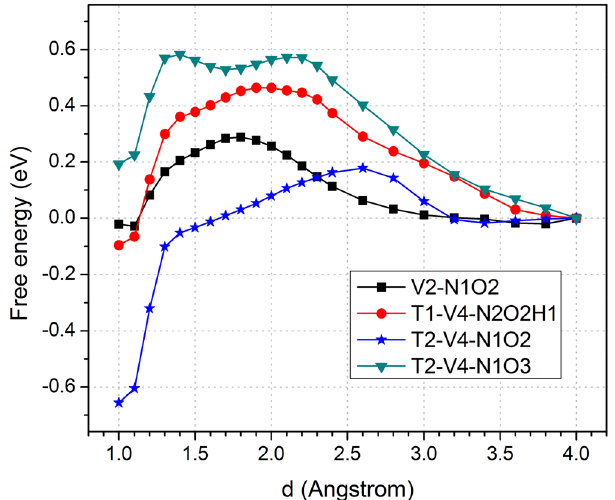
Figure 4. Proton transport free energy profiles for V2-N1O2, T1-V4-N2O2H1, T2-V4-N1O2 and T2-V4- N1O3 structures, respectively. Here the “d” along horizontal axis is the distance between the proton and the target site to be